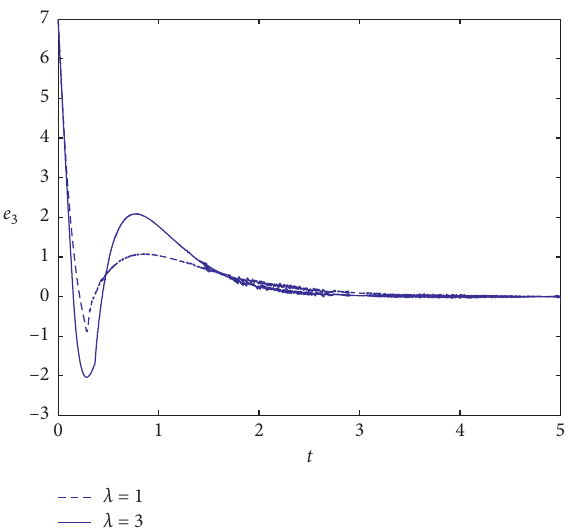
Figure 5: The time response of synchronization error variable e